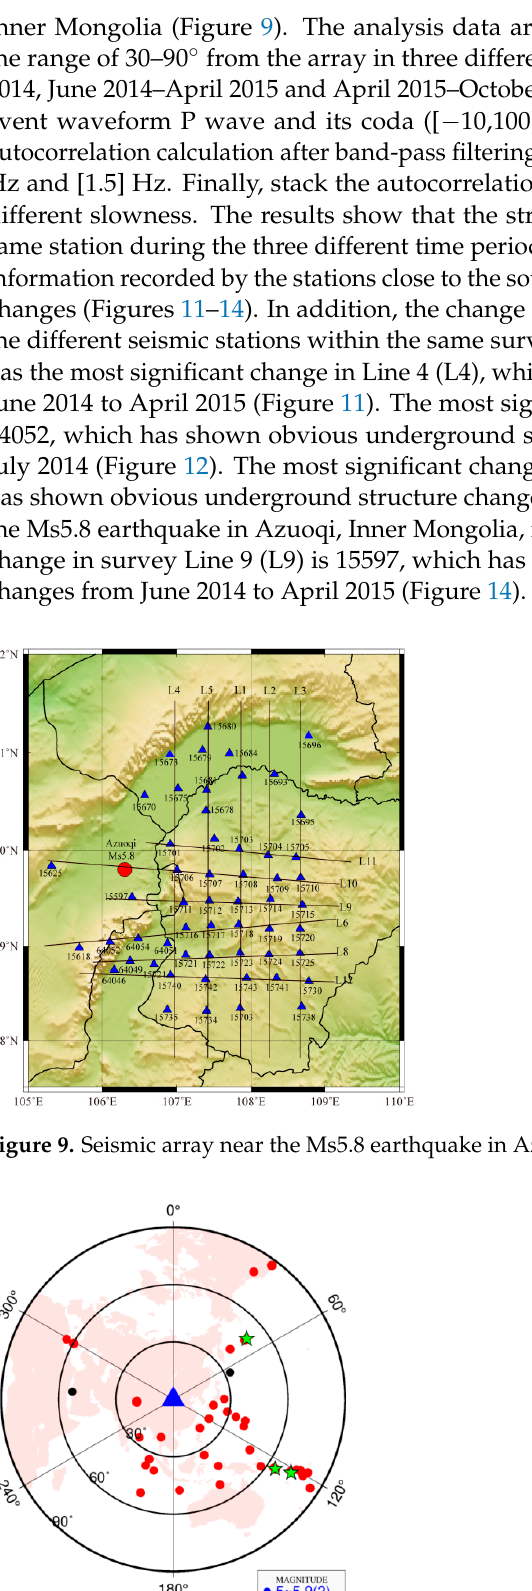
Figure 11. L4 (from left to right: 15673, 15675, 15701, 15706, 15711, 15716, 15721, 15740 and 15735) reflects the depth results of different frequency bands in three time periods from October 2013 to July 2014, June 2014 to April 2015 and April 2015 to October 2016, respectively.